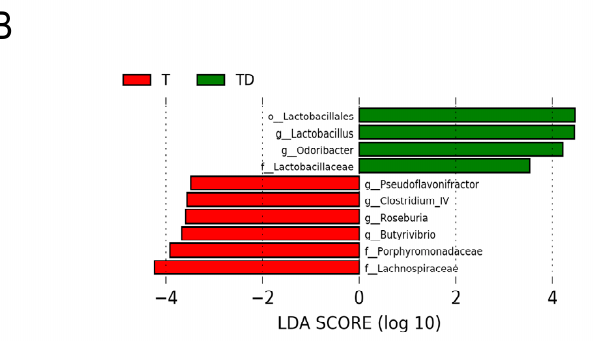
Figure 6. Effect of 3,3-Dimethyl-1-butanol (D) and 2,3,7,8-tetrachlorodibenzo-p-dioxin (T) on the gut microbiome in offspring. Linear discriminant analysis effect size (LEfSe) was carried out to identify microbial marker. Most enriched and depleted bacterial taxa in the ( A ) C (red) versus T group (green) and ( B ) T (red) versus TD group (green) are shown. The threshold on the linear discriminant was set to